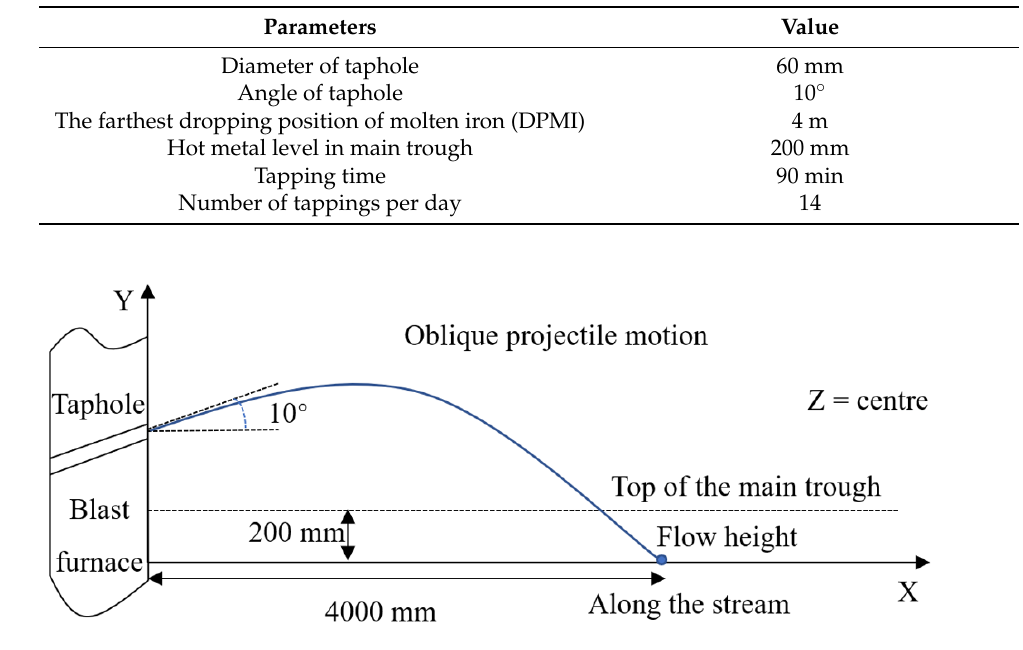
Figure 3. Dropping position calculation of the hot metal. Table 2. Tapping parameters of No. 2 BF in Lai Steel.